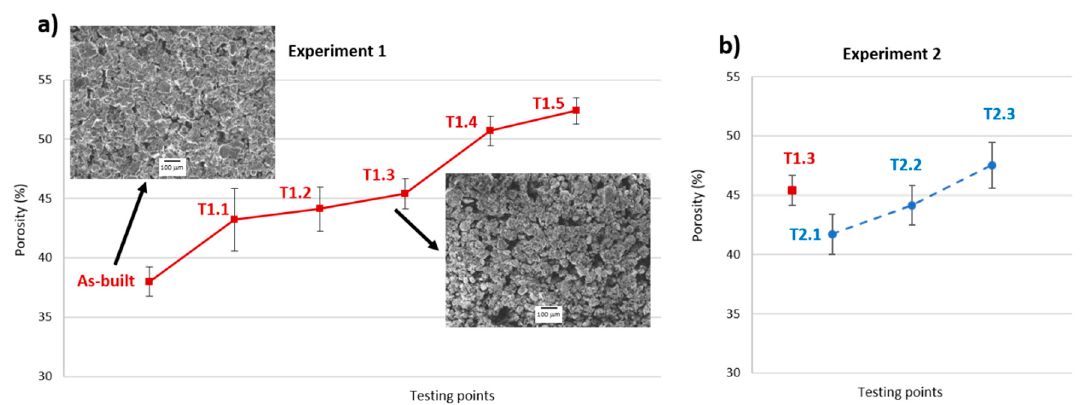
Figure 8. Porosity in the different testing points for both thermal treatments. ( a ) Experiment 1; ( b ) Experiment 2.